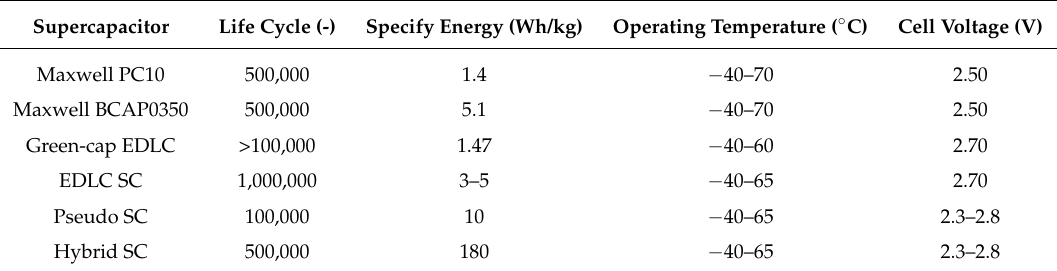
Table 3. Basic parameters of selected supercapacitors (SCs)